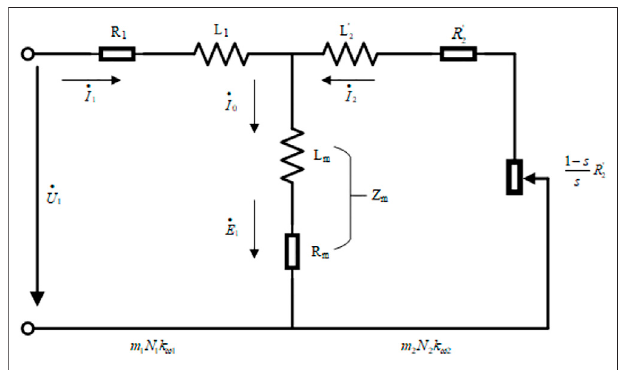
FIGURE 1 | T-type equivalent circuit of a three-phase asynchronous